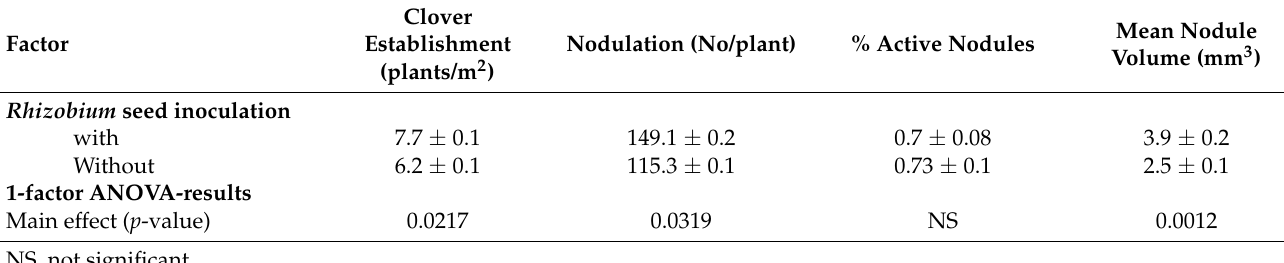
Table 4. Effect of Rhizobium inoculation of clover seed on clover establishment, nodule number/plant, % active nodules and mean nodule volume in growing season 1 (2003). Values shown are main effect means ±